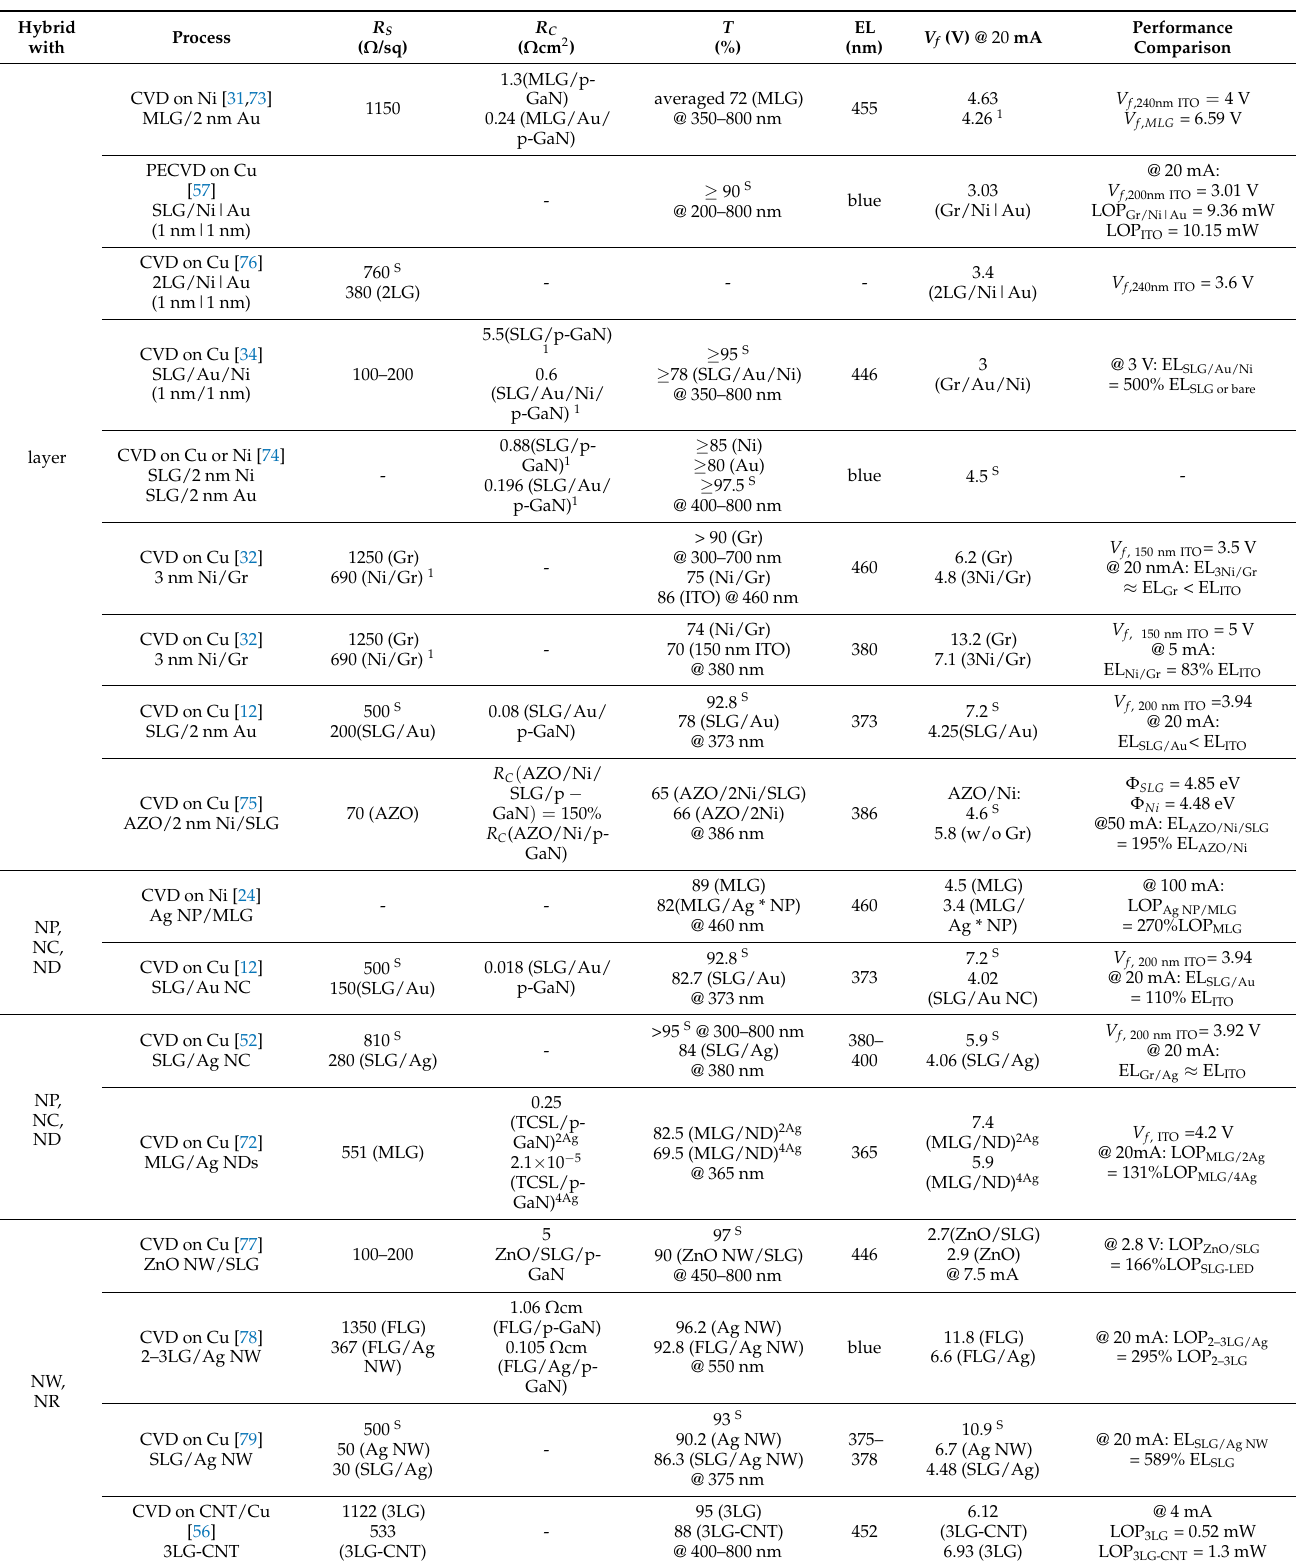
Table 4. Graphene combined with various metal configurations: layer, nanoparticle (NP), nanocluster (NC), nanodot (ND), nanowire (NW), nanorod (NR). Stack sequence from left to right is from upmost to p-GaN. CNT denotes carbon